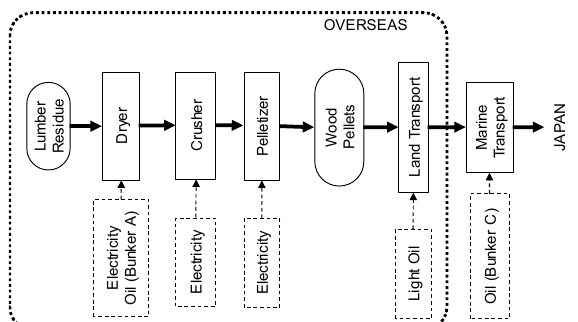
Figure 1. Flow chart of the WP and CP production and transportation processes: ( a ) WP; ( b ) CP.